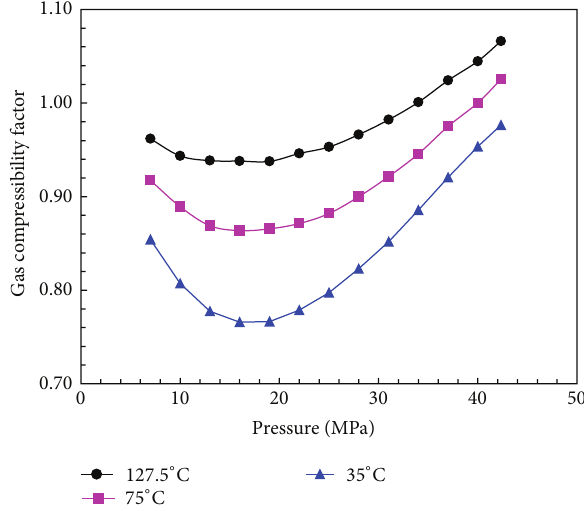
Figure 8: Variation of the 𝑍 -factor of YP9 gas sample with pressure under different